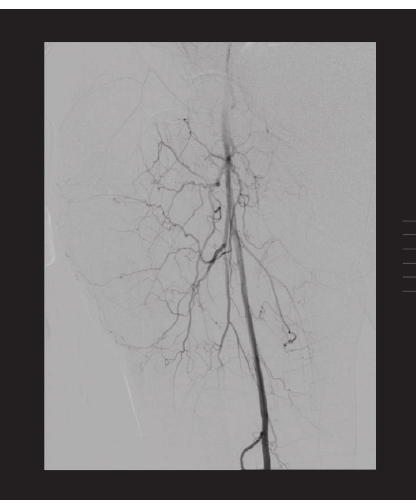
Figure8:Rightlowerextremityangiogramdemonstratesvaguearea of extravasation.